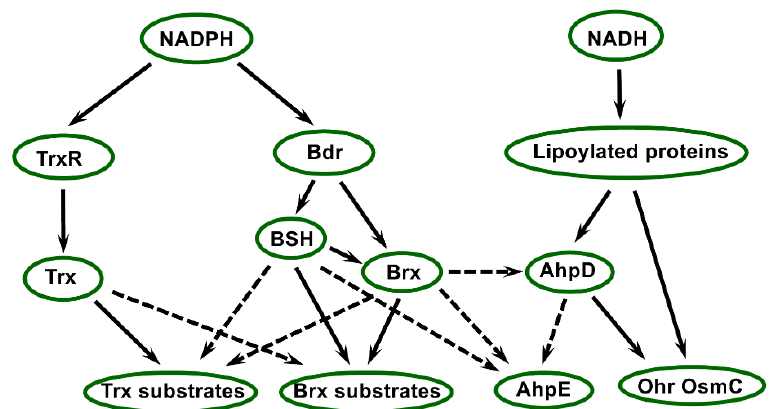
Figure 5. Relationships and possible interplays between Deinococcus thiol reductase systems. Dashed arrows indicate possible transfer of electrons between Trx-, BSH-, and lipoylated-dependent systems. TrxR, thioredoxin reductase; Trx, thioredoxin; Bdr, NADPH–BSH disulfide reductase; BSH, bacillithiol; Brx, bacilliredoxin; Ahp, alkyl hydroperoxide reductase; Ohr, organic hydroper- oxide resistance enzyme; OsmC, osmotically induced bacterial protein C.